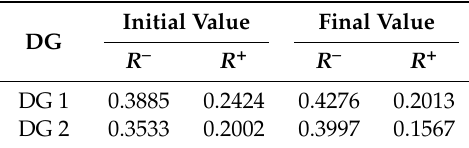
Table 3. Droop Constants for DGs (Unit: VAr/W).